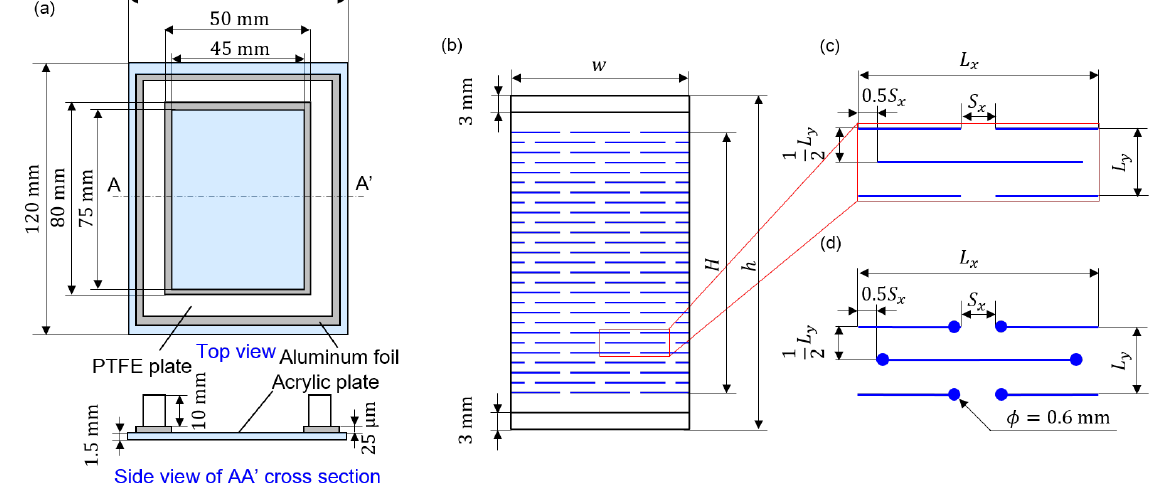
Figure 1. Schematic diagrams of ( a ) the aqueous CNF dispersion container to dry the CNF dispersion, and ( b – d ) Kirigami structures: ( b ) The specimen with a cut pattern of staggered dashed lines (or “ Amikazari ) is represented by the blue lines. ( c ) The pattern consists of a unit where the specific set of L x , L y , S x , and H determines the pattern, whereas w and h determine the size of specimen. The gaps of 3 mm on each side of the specimen are in direct contact with the chucks of the tensile testing system. ( d ) Basic and versatile design variation of the Kirigami pattern with the round-edge cutting line is schematically shown. It should be noted here that the design is based on the center lines of a laser processing trajectory and the actual cut lines include round edges have finite